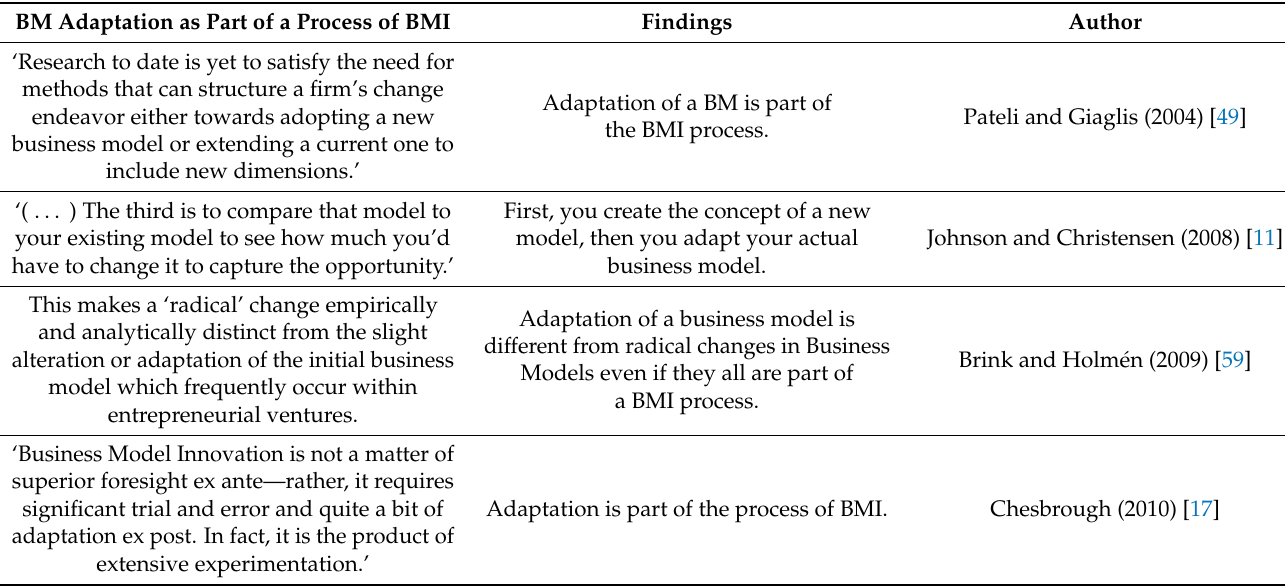
Table 4. Business Model Adaptation as a component of BMI.